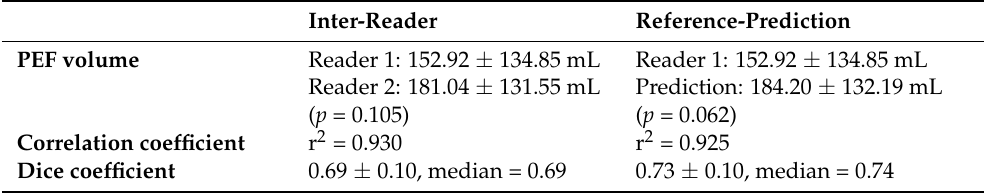
Table 3. Overview of inter-reader and reference-prediction